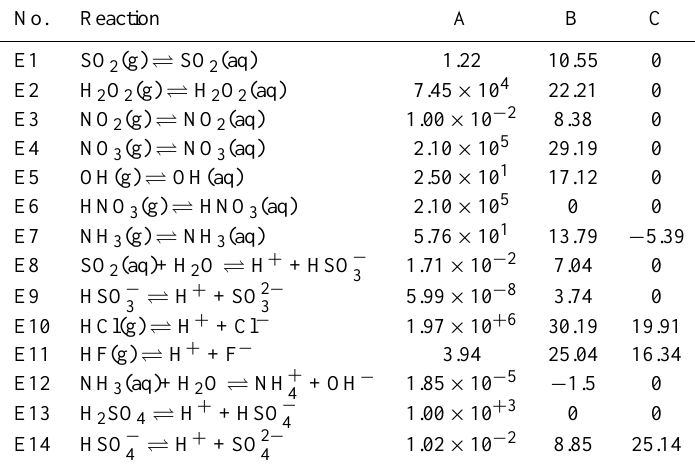
Table A2. Equilibrium reactions and rate coefficients (Jacobson,